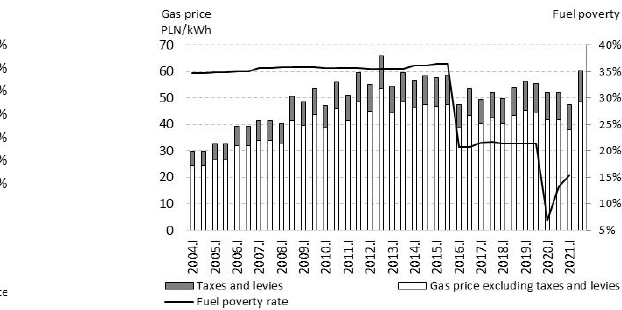
Figure 2. Decomposition of electricity and gas prices vs. fuel poverty rate in Poland in 2004–2021.